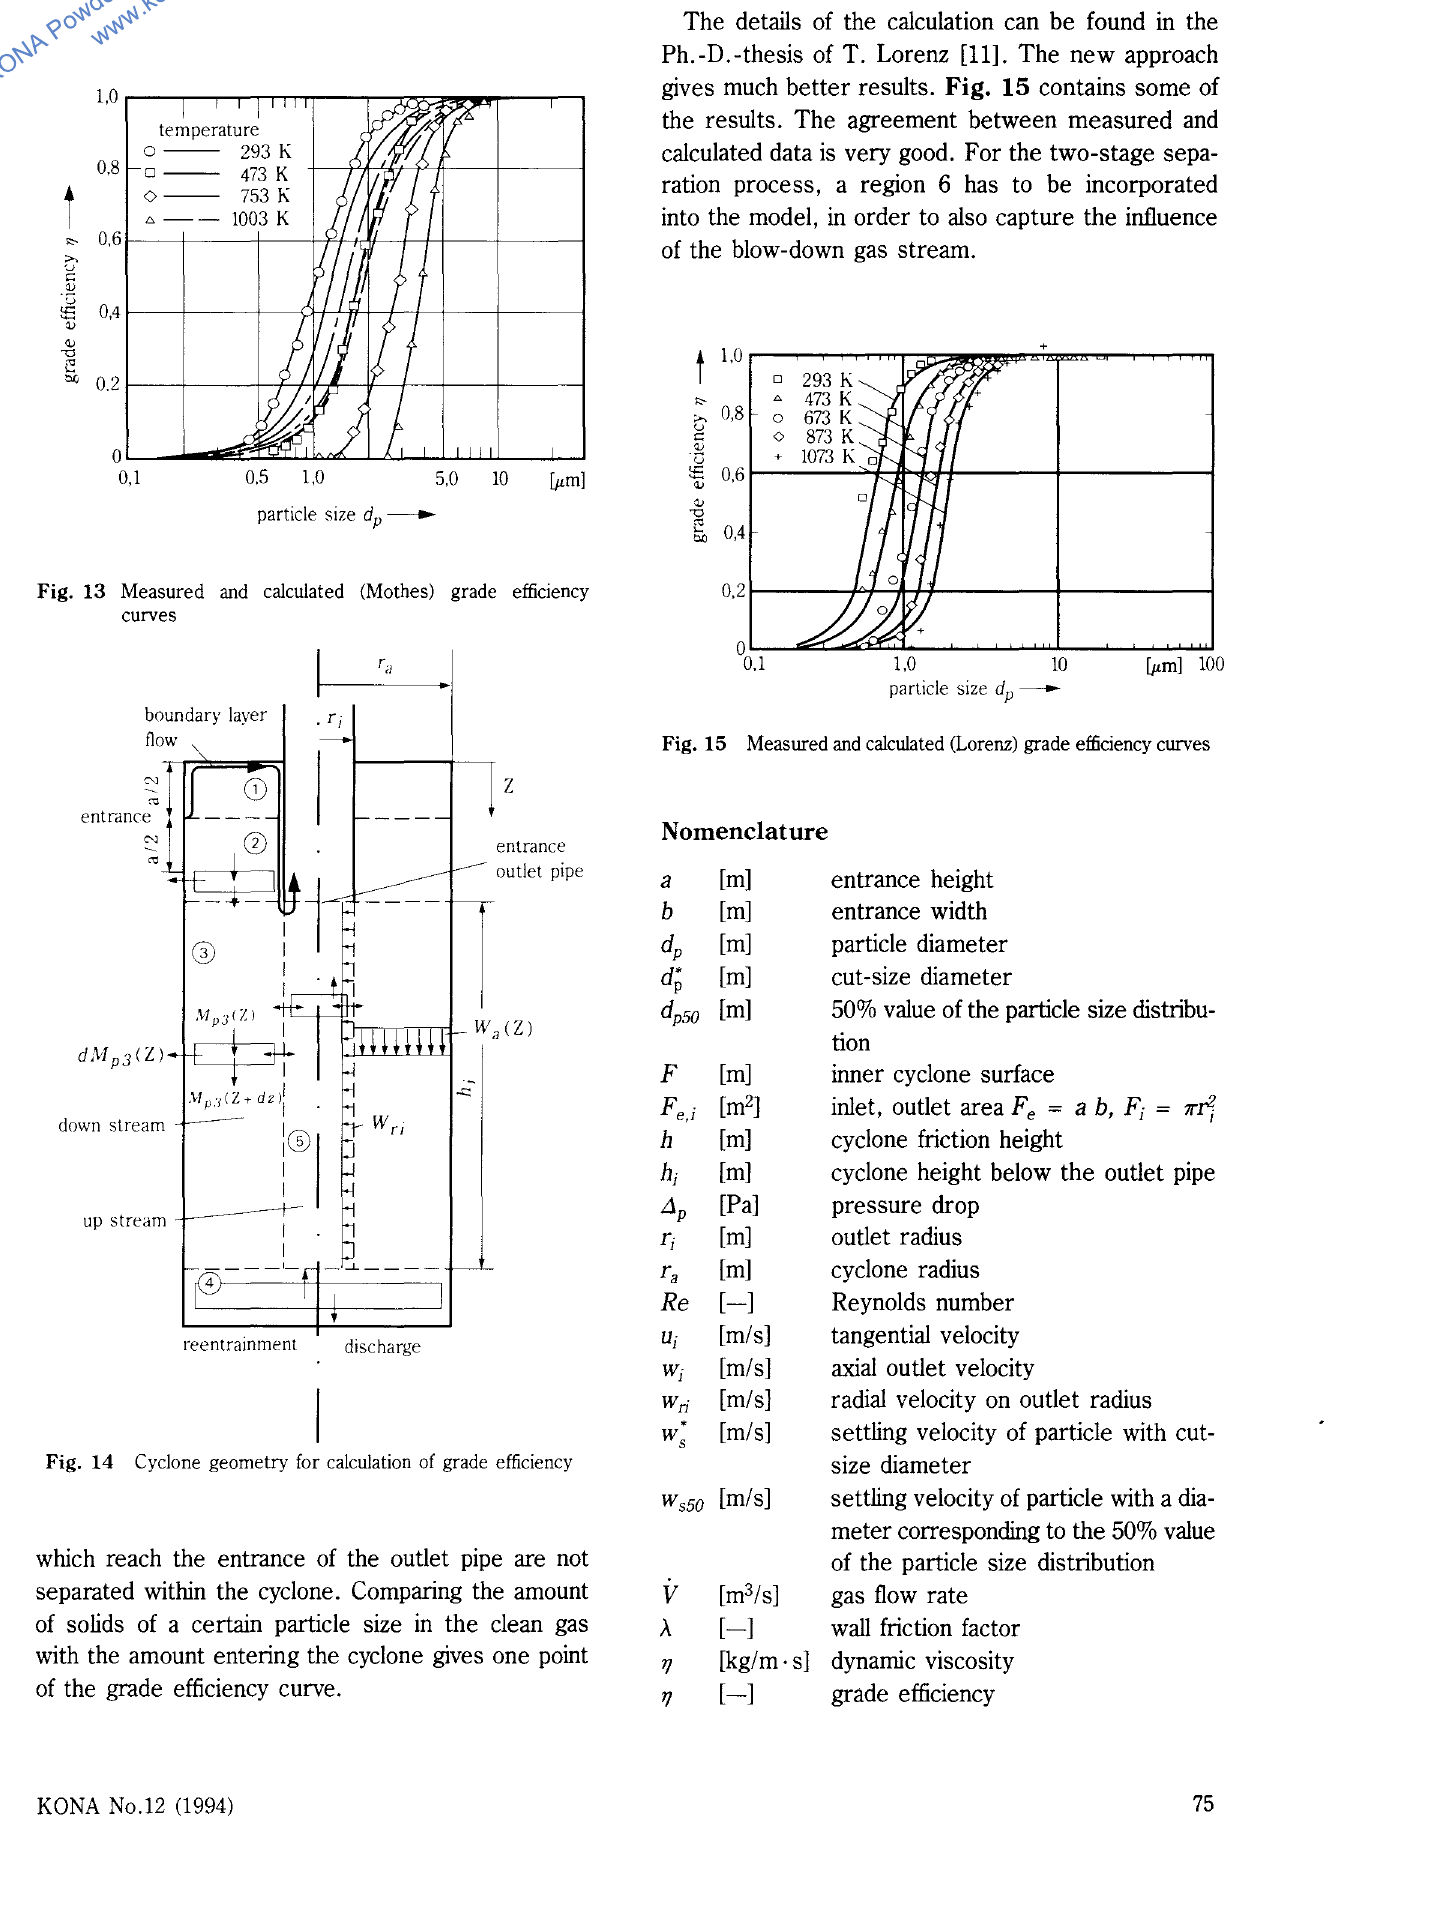
Fig. 14 Cyclone geometry for calculation of grade efficiency